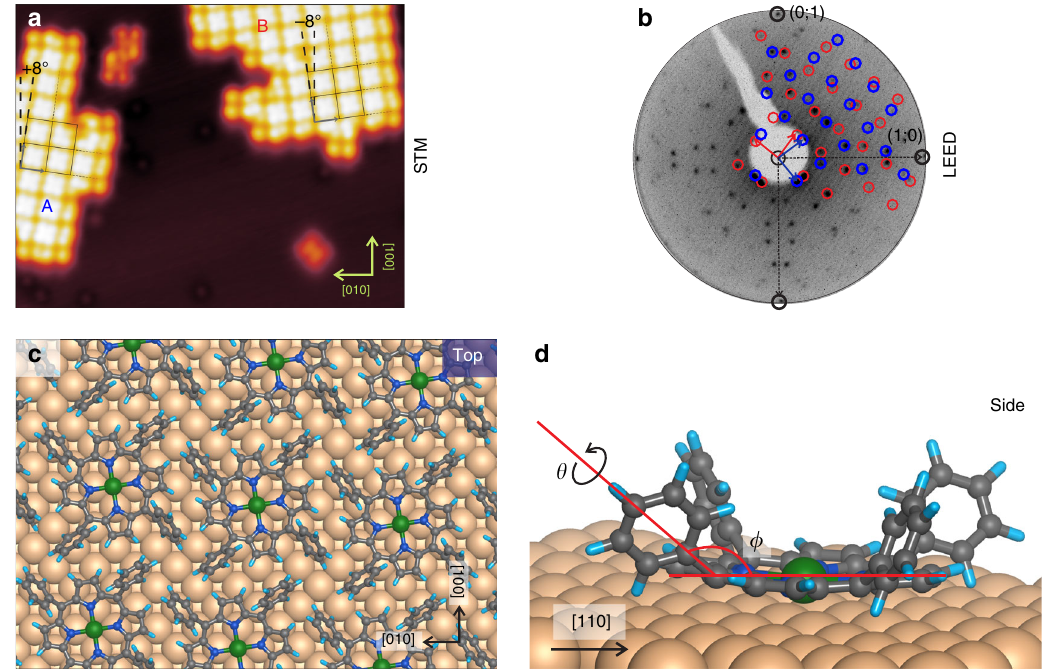
Fig. 2 Adsorption geometry of close-packed Ni-TPPs. a STM image including two Ni-TPP domains, labeled with A and B, respectively. STM image parameters: V b = − 1.5 V, I t = 0.2 nA, image size 15 × 20 nm 2 , measured at 4.3 K. b LEED pattern of Ni-TPP/Cu(100) acquired at E K = 45 eV. The simulated structure is superimposed: blue and red spots correspond to A and B domains, respectively. Proposed adsorption model for Ni-TPP/Cu(100): c top view and d side